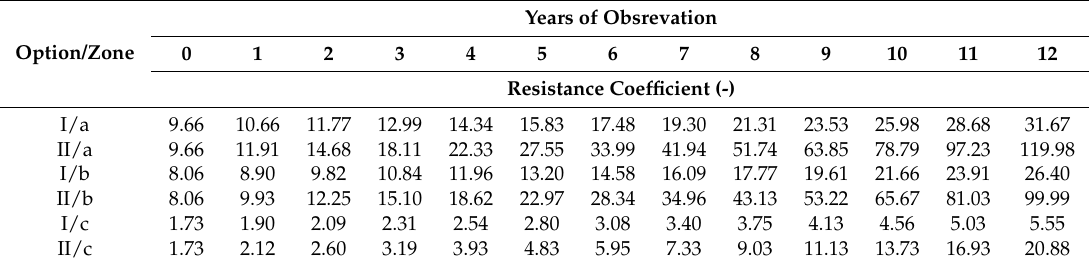
Table 2. Change in the resistance coefficient for the analysed scenarios in three test